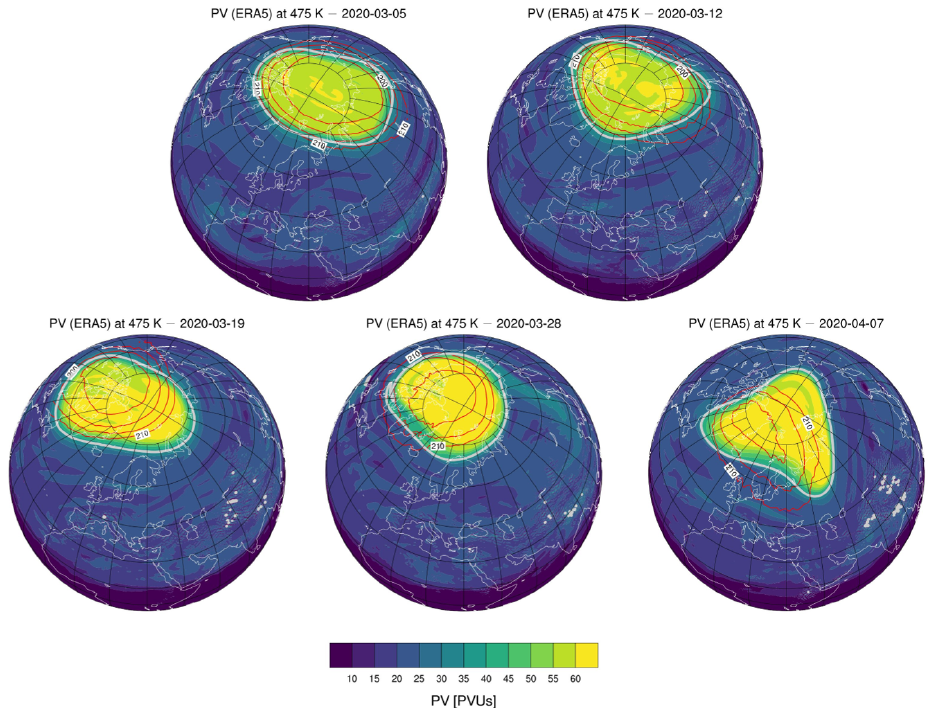
Figure 2. Potential vorticity (PV) on the 475K isentropic surface over the Northern Hemisphere on 5, 12, 19, 28 March and 7 April 2020 based on ERA5. The color scale shows potential vorticity units (PVUs); 1 PVU is 10 − 6 m − 2 s − 1 Kkg − 1 . The grey contour highlights the 36 PVU. Red contour lines indicate the polar temperature field, with values ranging from 210 to 195K; the distance of isolines is